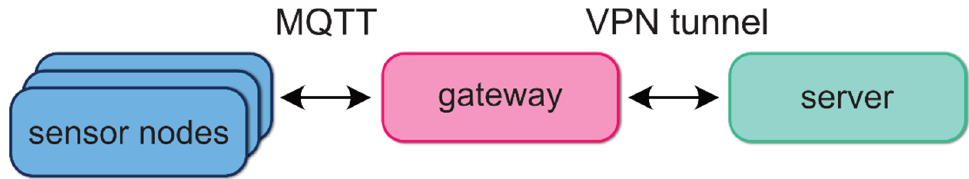
Figure 3. Overview of the main components.